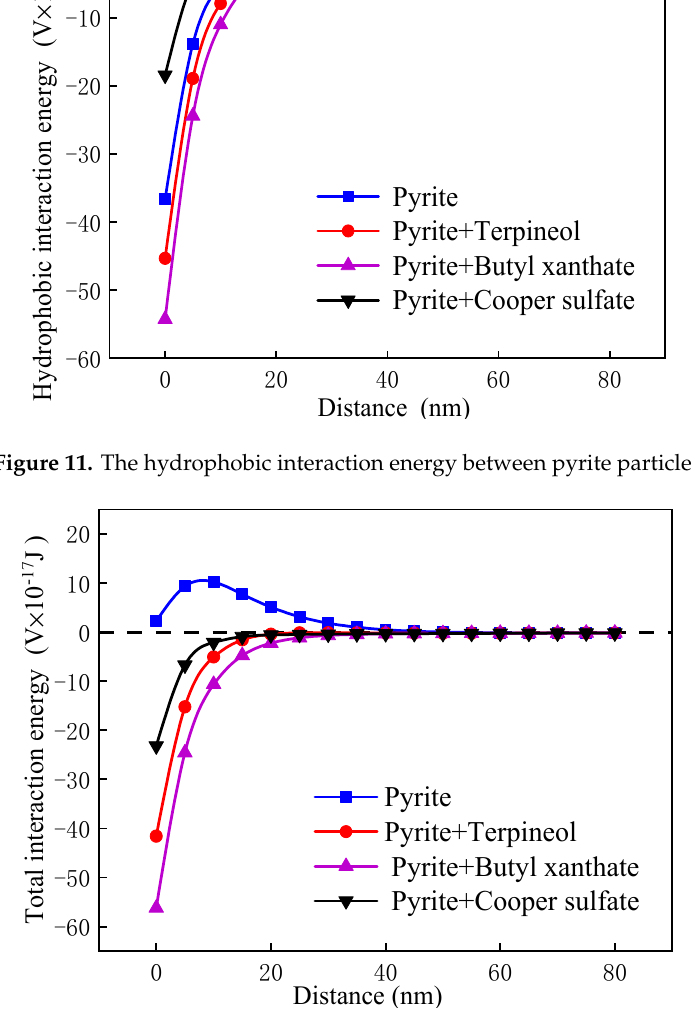
Figure 12. The total interaction energy between pyrite particles.